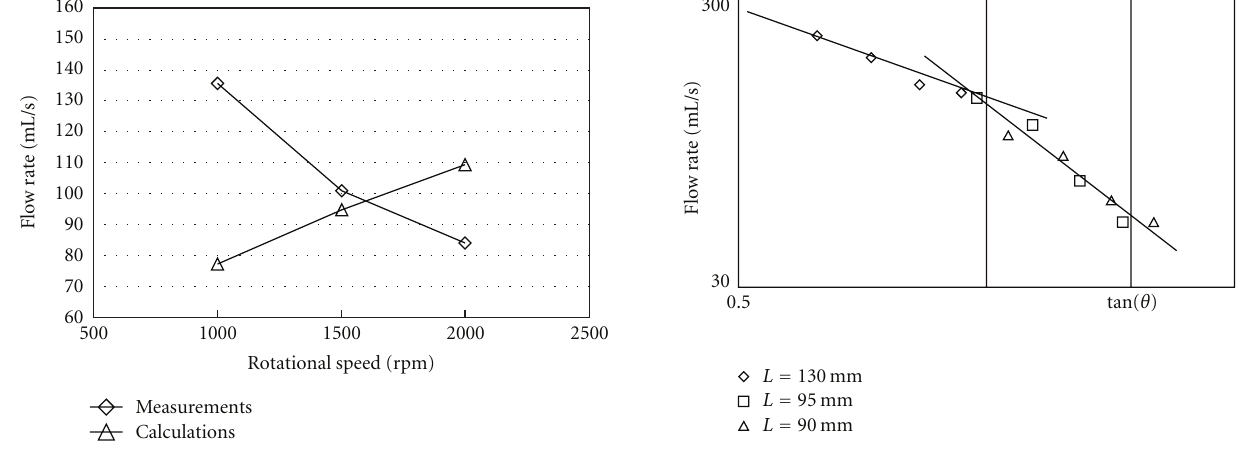
Figure 10: Oil flow rate versus angle θ